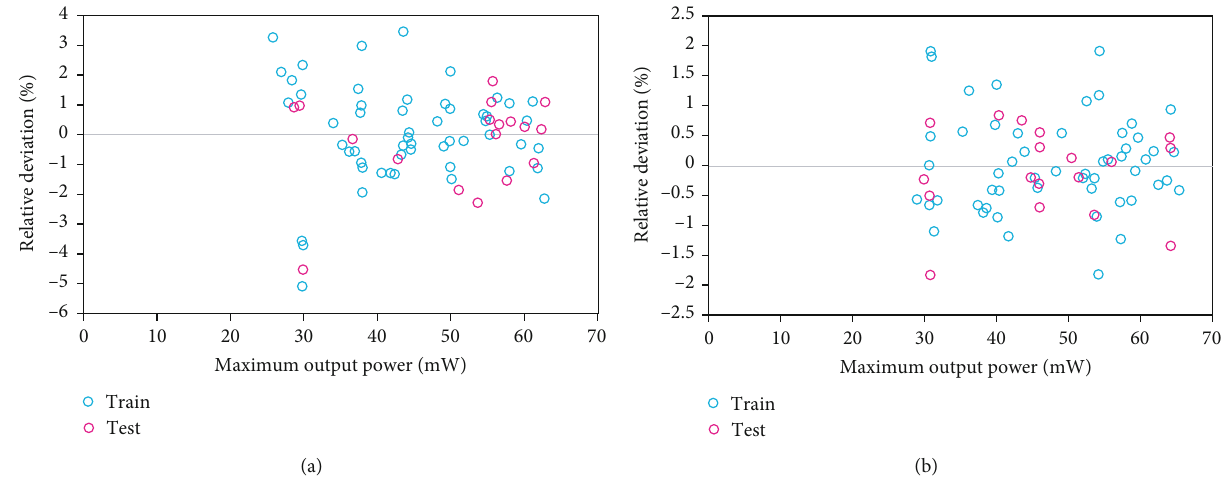
Figure 8: The relative deviation between experimental and predicted maximum output power by LSSVM for (a) monocells and (b) Table 1: Statistical evaluations of models.